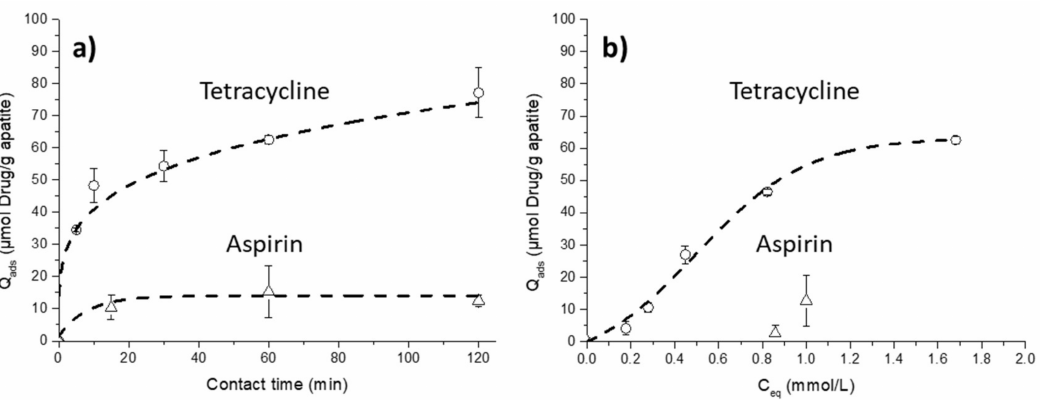
Figure 3. Drug adsorption on biomimetic apatite powder: ( a ) adsorption kinetics at pH = 7.4, room temperature and ( b ) adsorption isotherms at pH = 7.4, room temperature for 1 h; two drug adsorptions are performed with tetracycline (o) and aspirin ( ∆ ) using experimental protocol